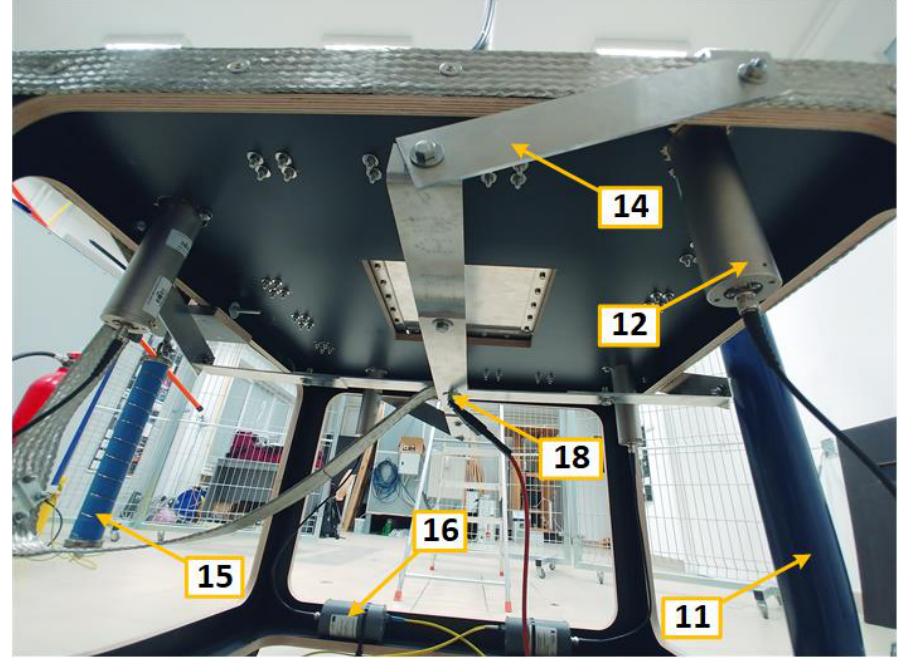
Figure 3. The bottom view of the test bench: 11 — high-voltage divider, 12 — current shunt, 14 — alu- minum bar, 15 — pulse forming part, 16 — fiber optic system transmitter, 18 — connection point. bar, 15—pulse forming part, 16—fiber optic system transmitter, 18—connection